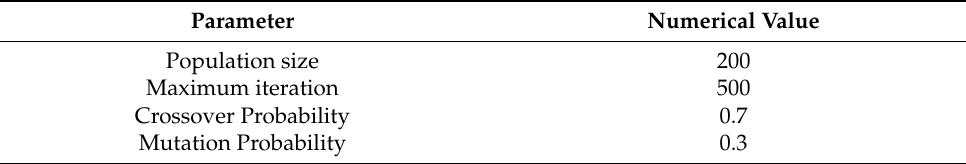
Table 1. Parameters of the proposed GA.